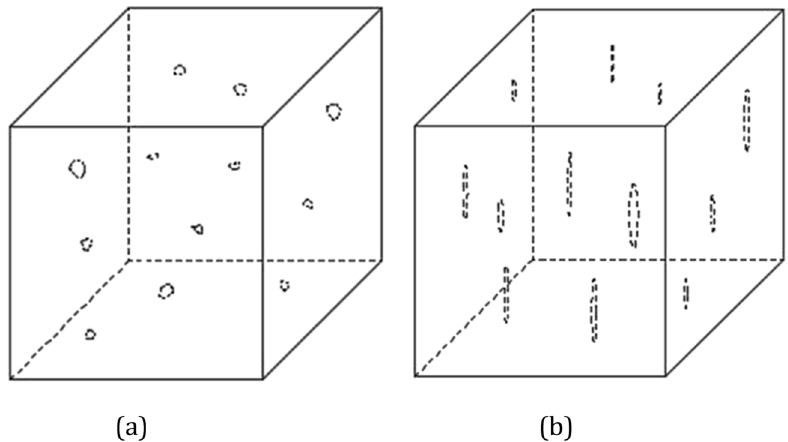
Figure 2: The representative volume element showing ( a ) microscopic defects and ( b ) the cracks into which they